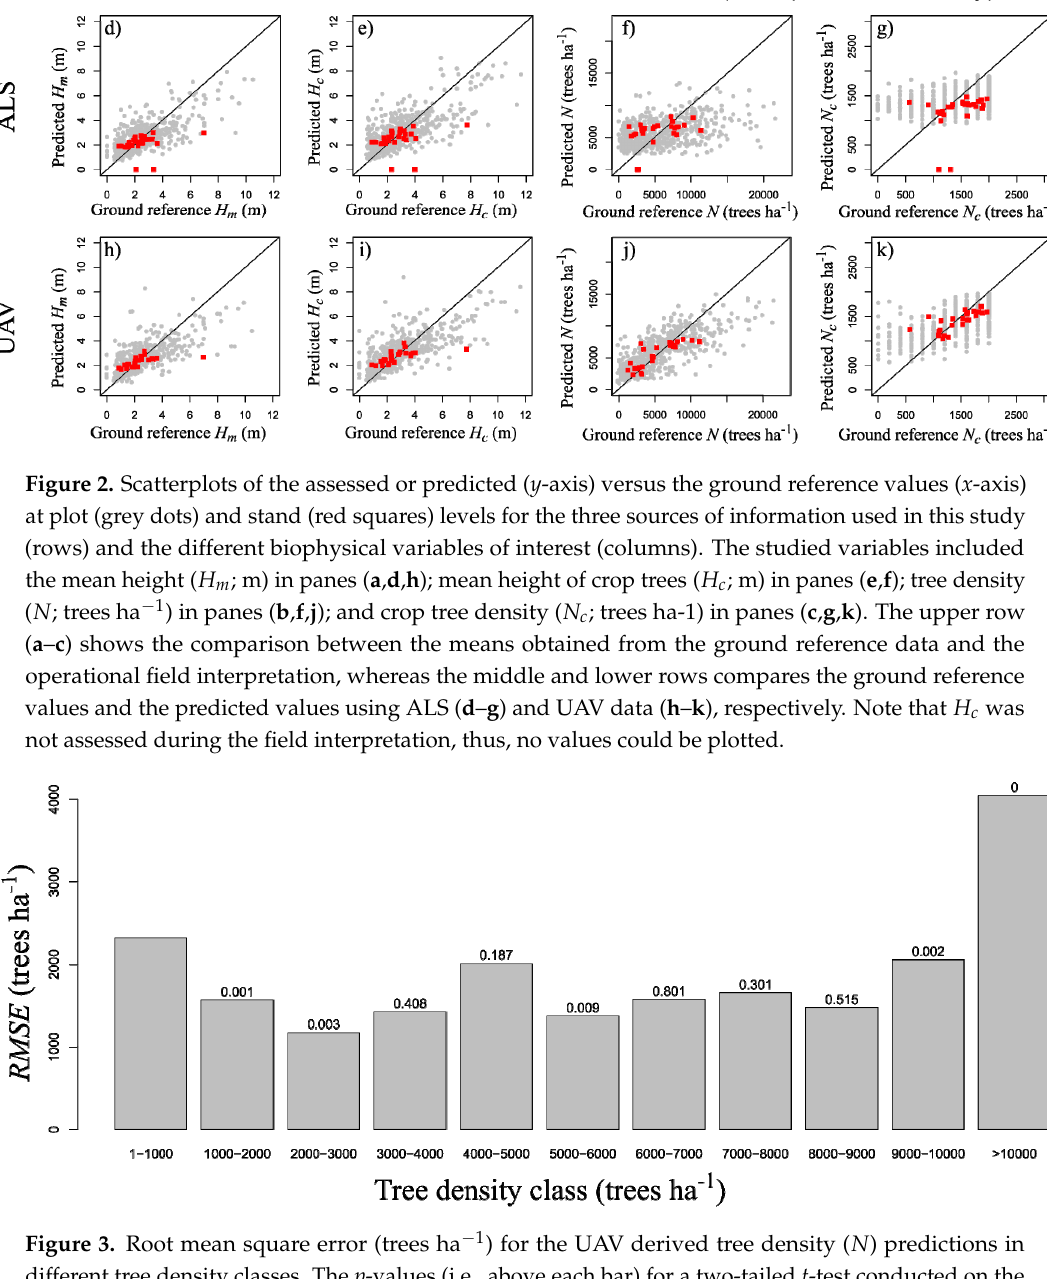
Figure 3. Root mean square error (trees ha − 1 ) for the UAV derived tree density ( N ) predictions in different tree density classes. The p -values (i.e., above each bar) for a two-tailed t -test conducted on the residuals of one class with the residuals of the previous class were reported to describe whether the changes were significant.